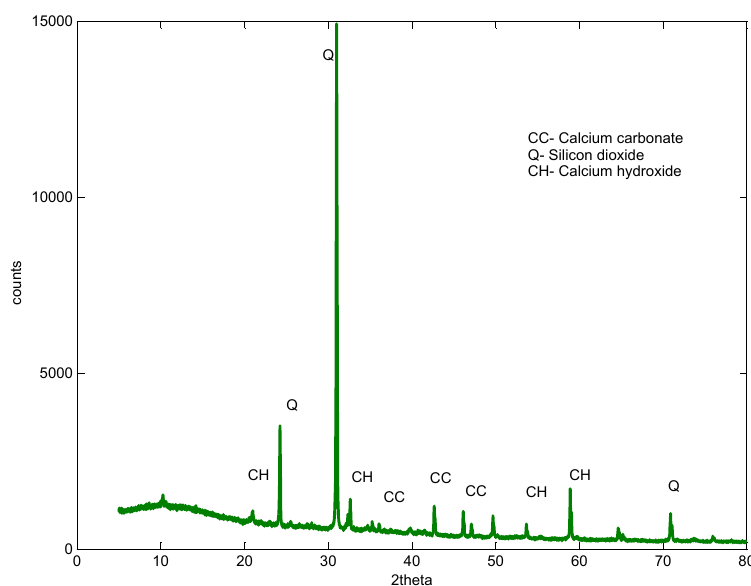
Figure 13. Two percent dosage XRD sample at 56 days w/b = 0.56.